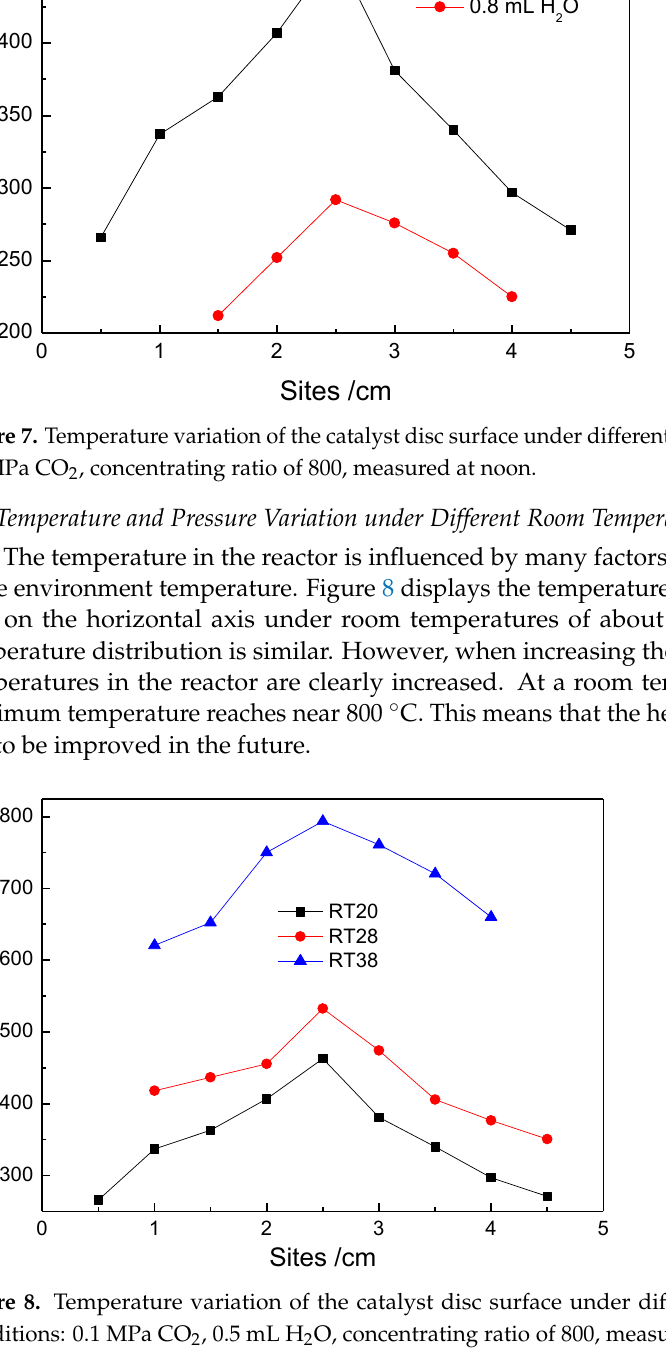
Figure 8. Temperature variation of the catalyst disc surface under different room temperatures. Conditions: 0.1 MPa CO 2 , 0.5 mL H 2 O, concentrating ratio of 800, measured at noon. 4.5. CO 2 Photoreduction Performance under Concentrated Solar Light The concept of process intensification via the concentrated solar reaction system was then verified under simulated and real solar light, as shown in Figures 9 and 10 .